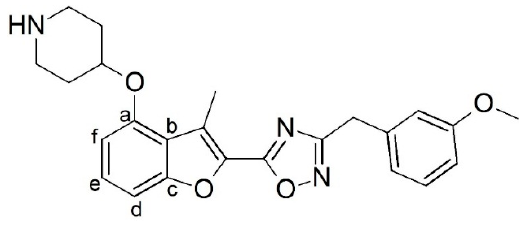
Figure 10. Ordered atom letter codes (a–f) used in the 4D-QSAR analysis defines the three trial alignments. Compound 81 (pIC 50 = 7.301) is used to define the atom letter code.